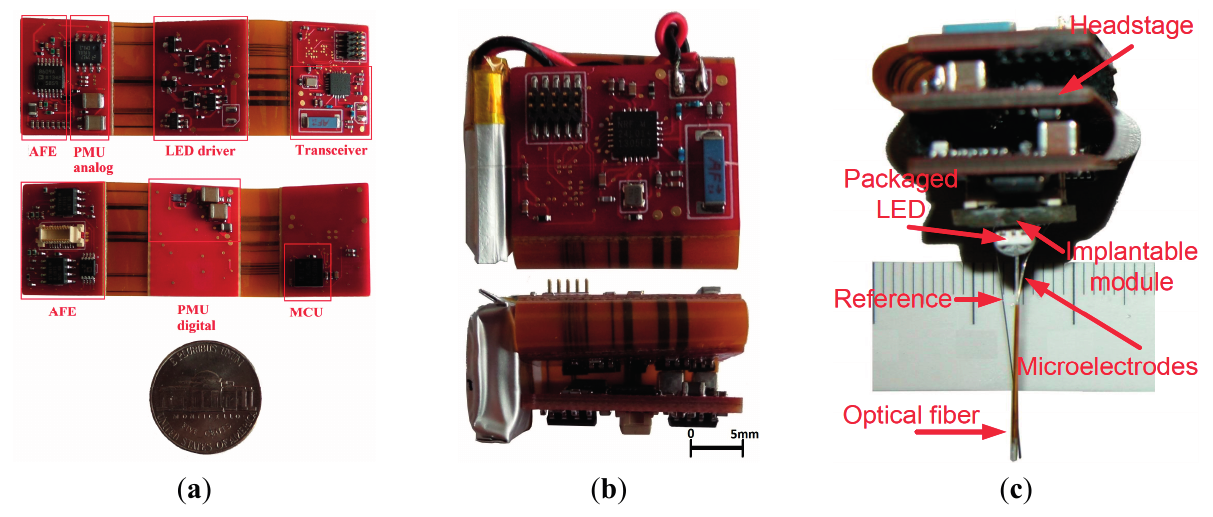
Figure 6. ( a ) Two-sided view of the unfolded rigid-flex PCB; ( b ) The folded system